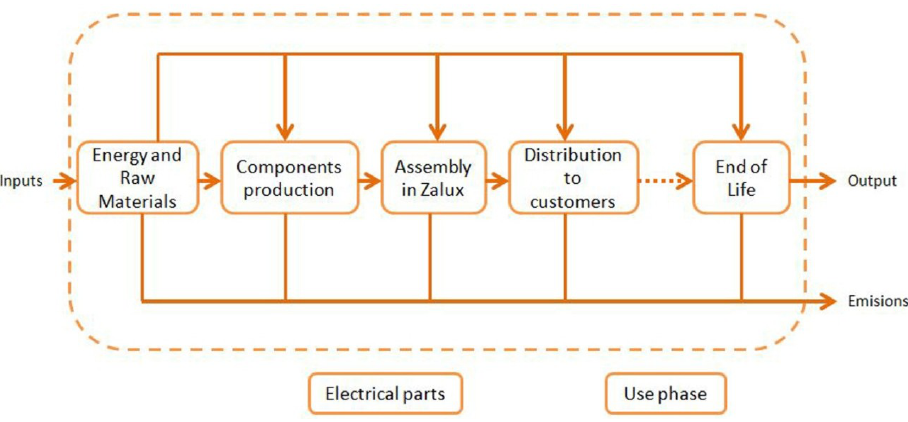
Figure 2. Life cycle system boundaries